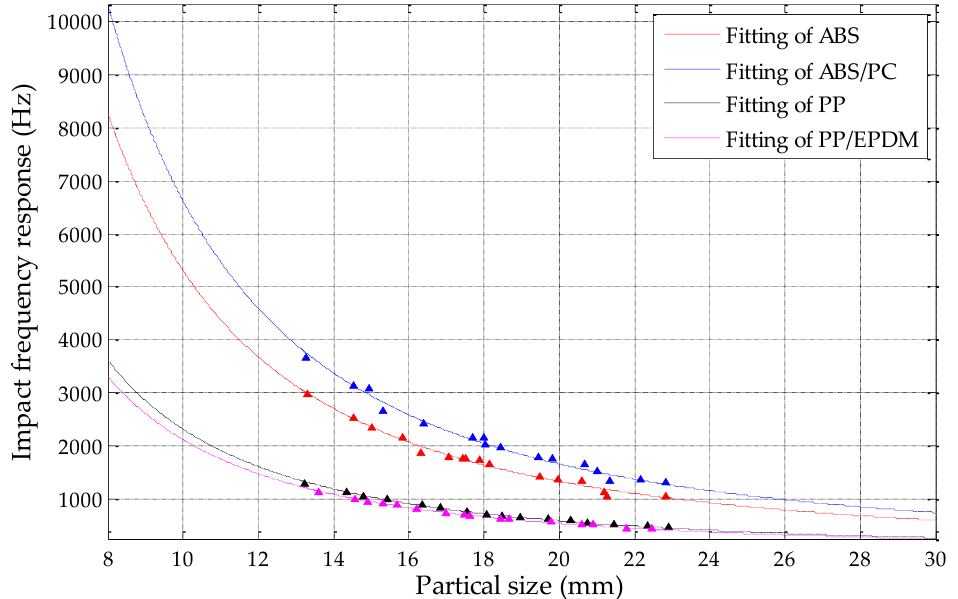
Figure 16. Fitting analysis of four samples’ impact frequency response.